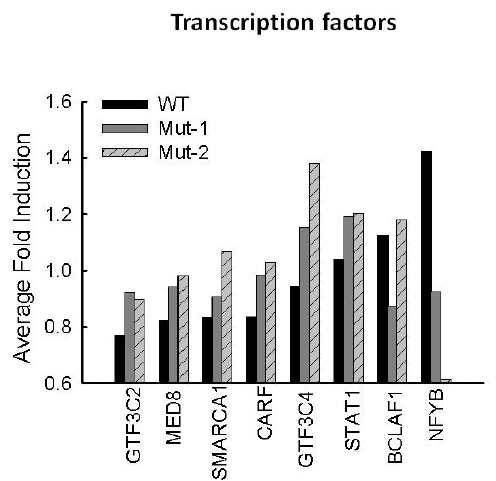
Figure 4. Nuclear transcription factors affected by M2-2 motifs. Detected transcription factors were analyzed as described in the Supplementary Table S1. Motif-affected transcriptional factors are summarized and